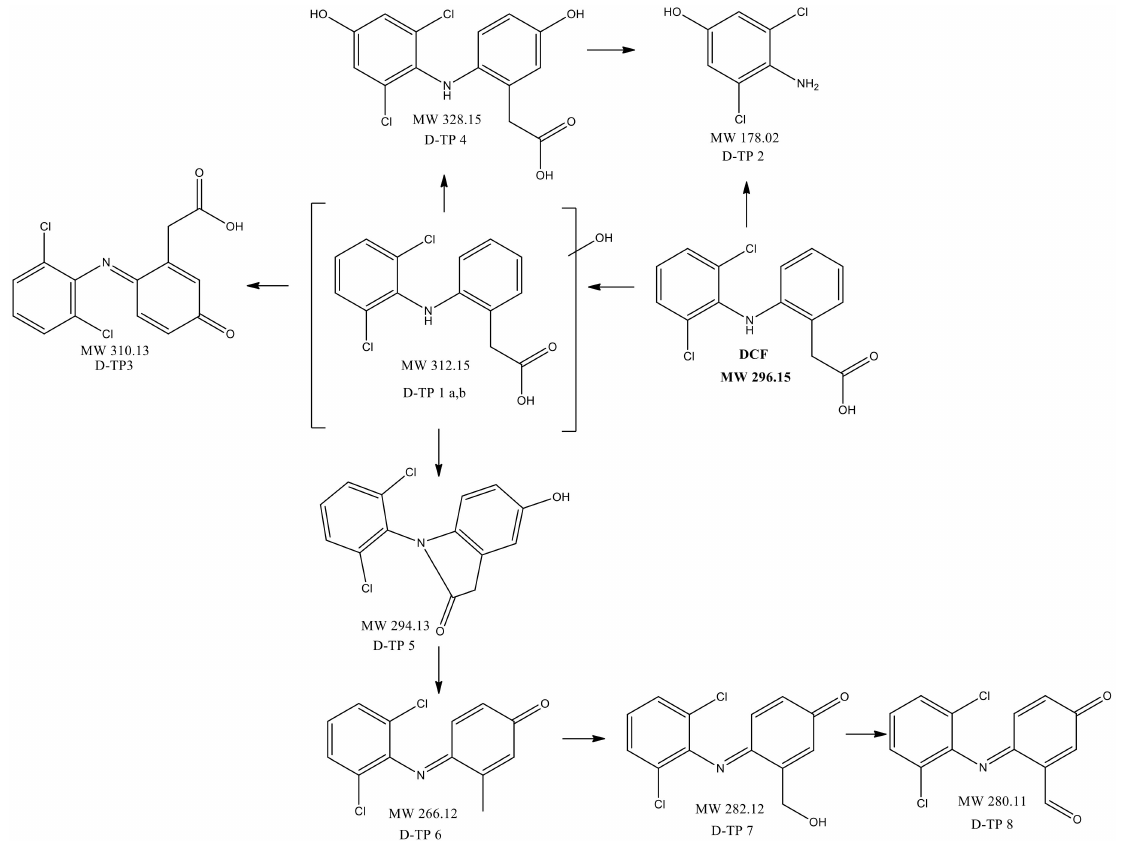
Figure 10. TPs products generated from DCF by PEF/TiO 2 20 wt% under